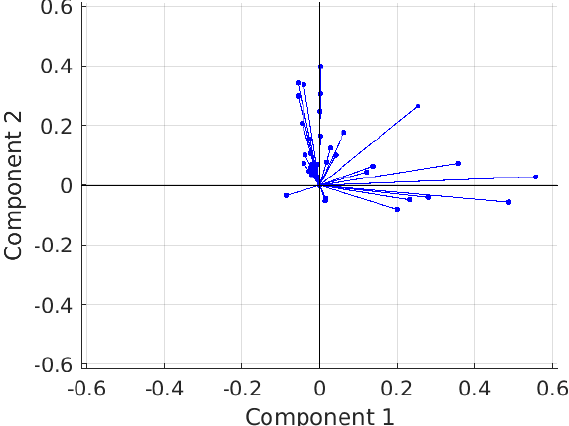
Figure 5. Biplot of principal component